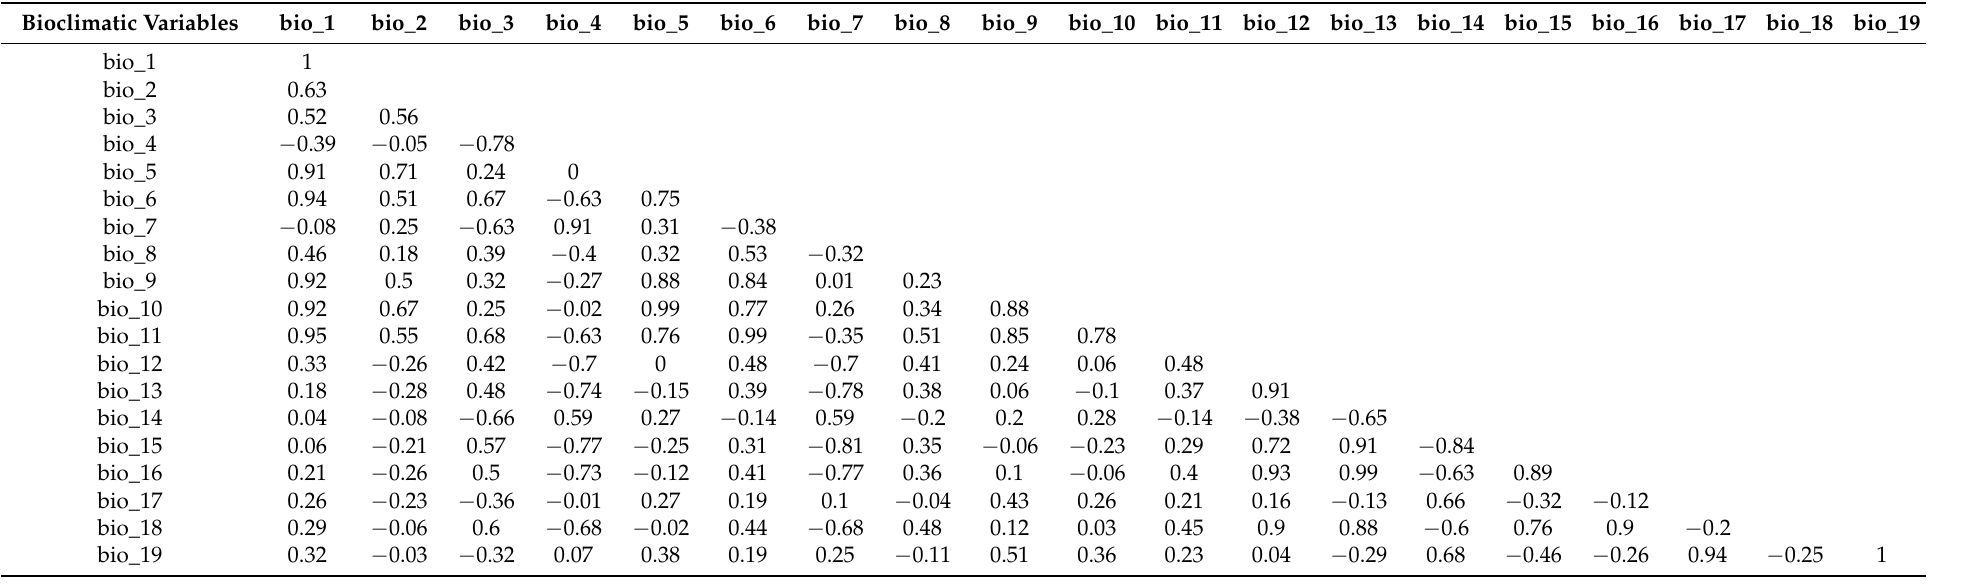
Table 2. Pearson’s correlation among nineteen different bioclimatic